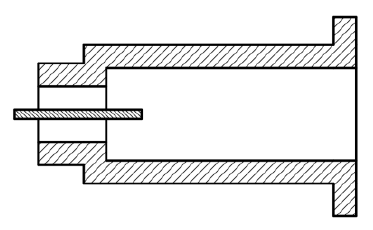
Fig. 2. Methods for exciting waves in a rectangular waveguide for E-type